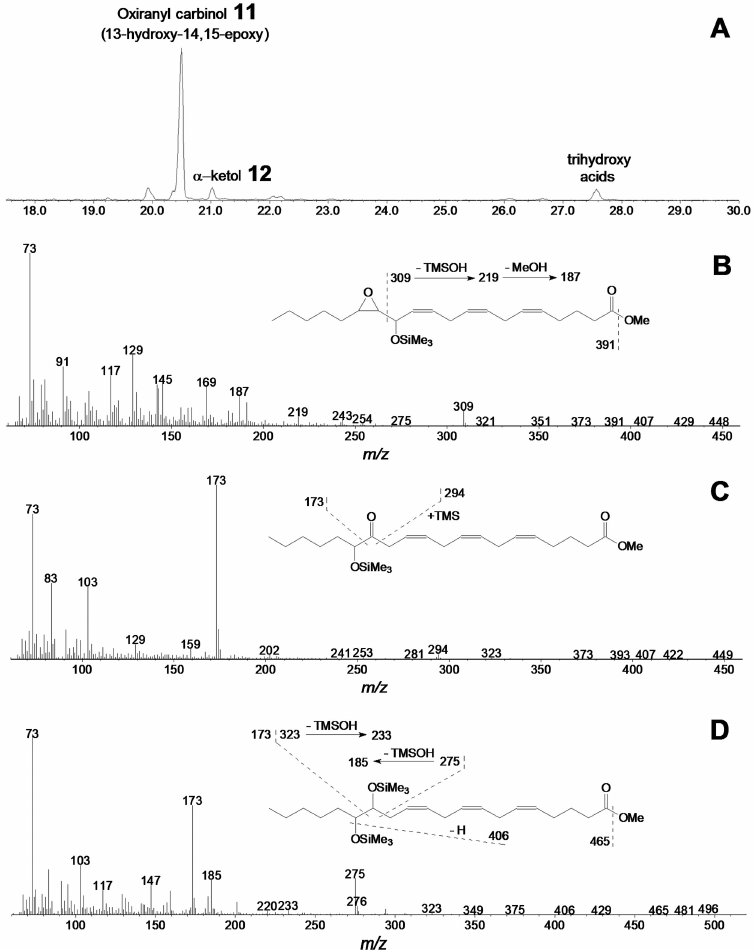
Figure 7. The result of GC–MS analysis of products (Me/TMS) of 15-HPETE incubation with recombi- nant CYP440A18 enzyme. ( A ) The total ion current GC–MS chromatogram of products (Me/TMS) of 15-HPETE incubation with recombinant enzyme. ( B ) The mass spectrum and fragmentation scheme (inset) for product 11 . ( C ) The mass spectrum and fragmentation scheme (inset) for product 12 . ( D ) The mass spectrum and fragmentation scheme (inset) for product 12a . Conditions of incubation, extraction, derivatization, and analysis are described in the Materials and Methods section. Structures of products are presented in Figure